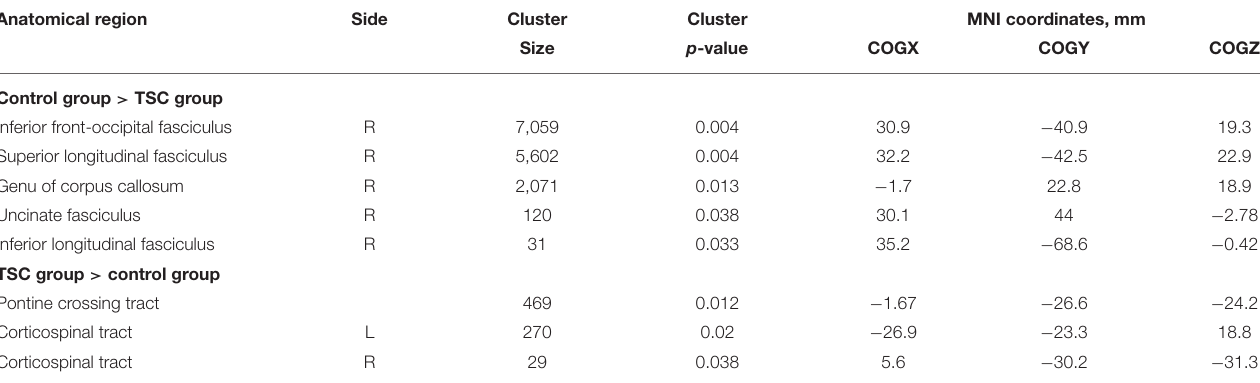
TABLE 3 | The regions showing significant FA differences between TSC and control group. Anatomical